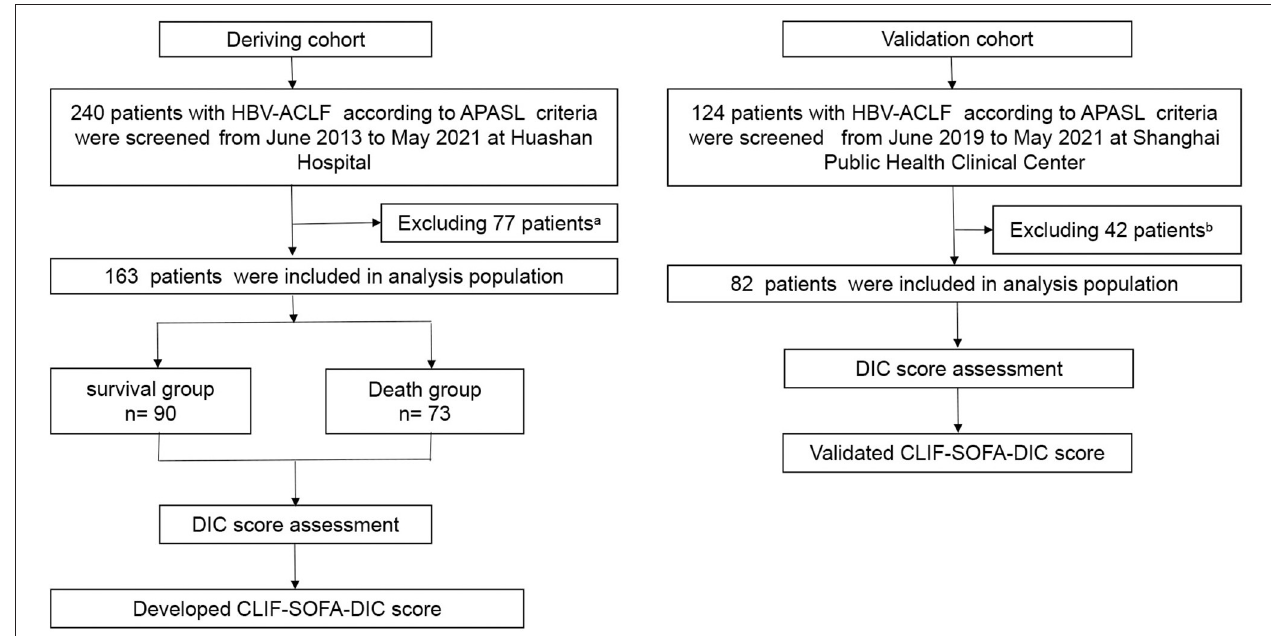
FIGURE 1 | Flow chart of the study design. a A total of 77 patients from the derivation cohort were excluded for one or more of the following reasons: 29 had hepatocellular carcinoma or other tumors; 12 had severe extra-hepatic diseases; 6 were receiving immunosuppressive drugs for reasons other than chronic liver diseases; 6 complicated with alcoholic hepatitis; 1 complicated with schistosomiasis cirrhosis; 2 complicated with Wilson disease; 14 had received liver transplants within 28 days; and 7 were lost to follow-up within 28 days. b A total of 42 patients in validation cohort were excluded for one or more of the following reasons: 13 had hepatocellular carcinoma or other tumors; 8 had severe extra-hepatic diseases; 2 were receiving immunosuppressive drugs for reasons other than chronic liver diseases; 12 complicated with alcoholic hepatitis; 1 complicated with schistosomiasis cirrhosis; 3 patients received liver transplants within 28 days; and 3 were lost to follow-up within 28 days. HBV-ACLF, hepatitis B virus-related acute-on-chronic liver failure; APASL, Asian Pacific Association for the Study of the